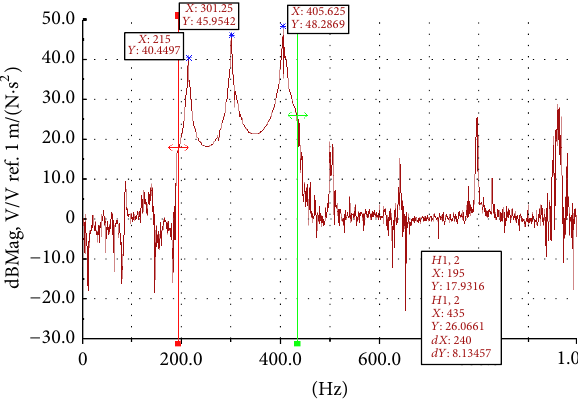
Figure 6: FRF ( 1/19 ) of the beam without the VDVN and excited in the frequency range of 200 to 430 Hz.